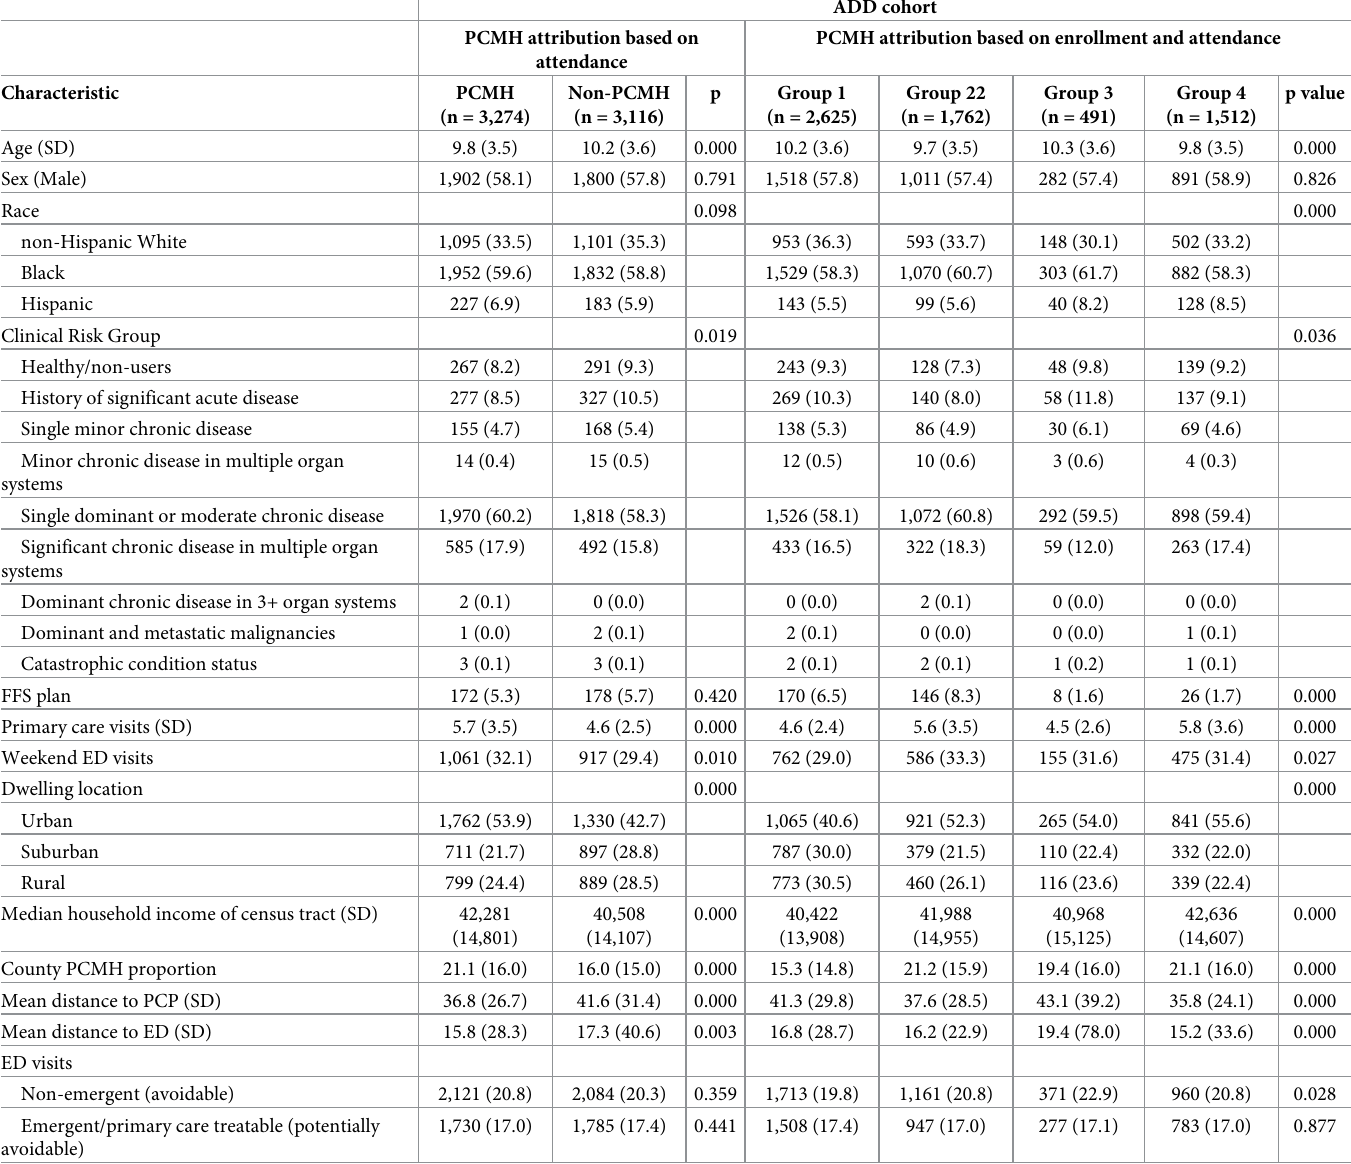
Table 2. Person-years summary statistics for MMA